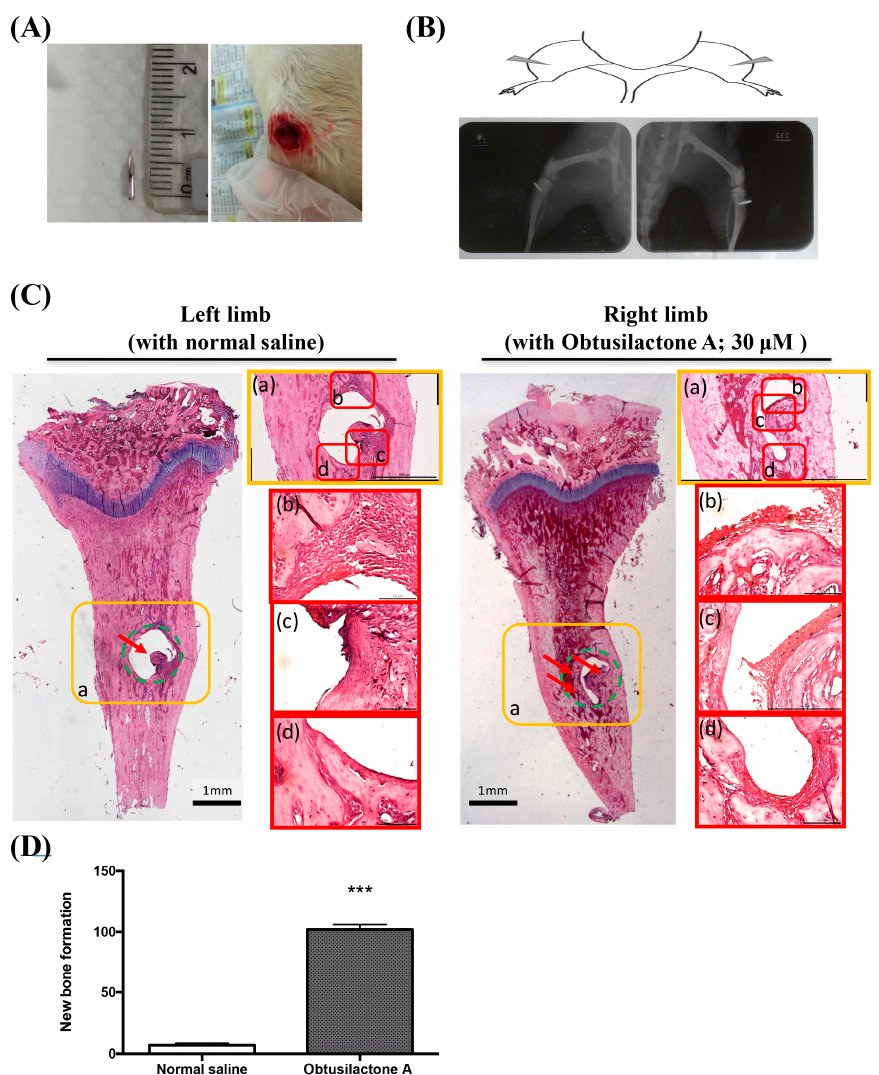
Figure 4. Evaluation of new bone formation via needle implantation of OA into the proximal tibial metaphysis of rats. OA (30 μ M, 30 μ L, once/two day) was locally administered into the tibia via a needle. ( A ) The cut tip of the needle (4 mm) and the posteriolateral side of the proximal tibial metaphysis in both hindlimbs. ( B ) Schematic view and X-ray film of the needle implantation side. ( C ) H&E staining of the needle implantation site in the OA-treated right tibia (right panel; enlarged a – d ) and normal saline-treated left tibia (left panel; enlarged a – d ) in rats after 14 days administration (green dotted line: the original size of the needle defect; red arrow: the new bone formation). ( D ) Quantified analysis of new bone formation inside the region of interest we selected as the original bone defect. *** p < 0.005.